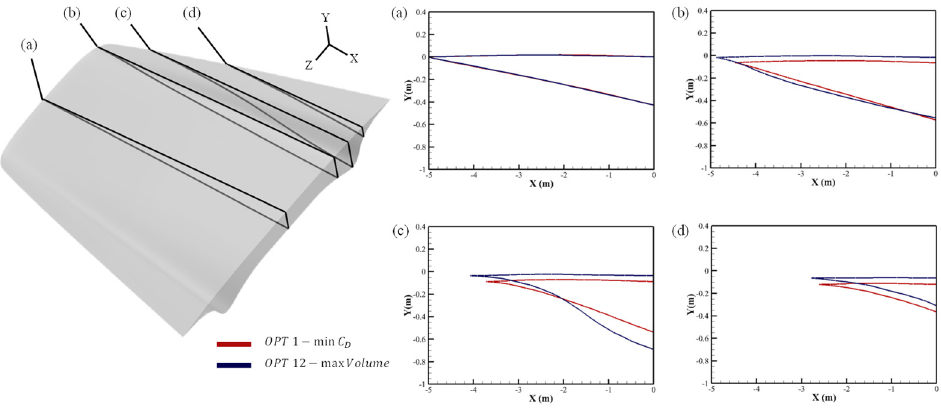
Figure 13. Lateral cross-sections diagram of OPT 1 and OPT 12; ( a ) z = 0 m; ( b ) z = − 1.4 m; ( c ) z = − 1.8 m; ( d ) z = − 2.2 m.